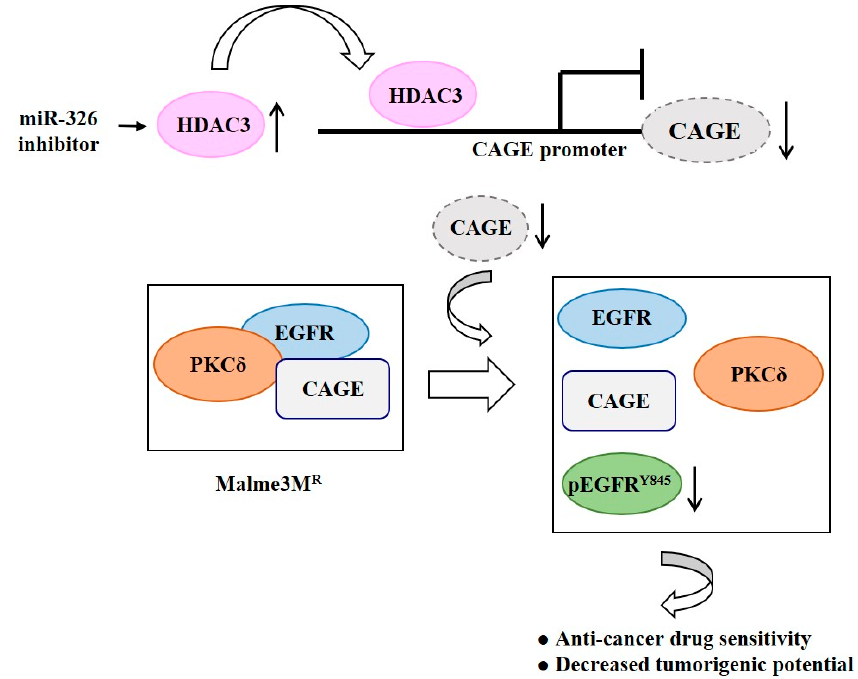
Figure 8. HDAC3 targets CAGE to inhibit EGFR activation. The MiR-326 inhibitor increases expression of HDAC3, which in turn induces binding of HDAC3 to the promoter sequences of CAGE. Decreased expression of CAGE leads to a disruption of interactions of CAGE with EGFR and protein kinase C gamma (PKC δ ) and decreased expression of pEGFR Y845 in Malme3M R cells. The ↑ arrows denotes increased expression level and ↓ arrows denotes decreased expression level.